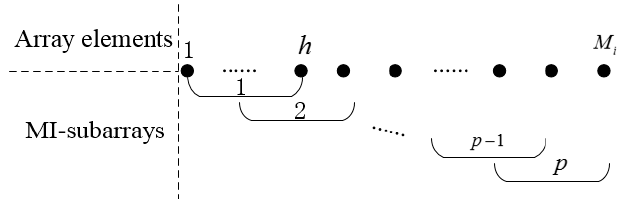
Figure 2. Array structure of the multiple invariance estimation of signal parameters via rotational invariance technique (MI-ESPRIT).